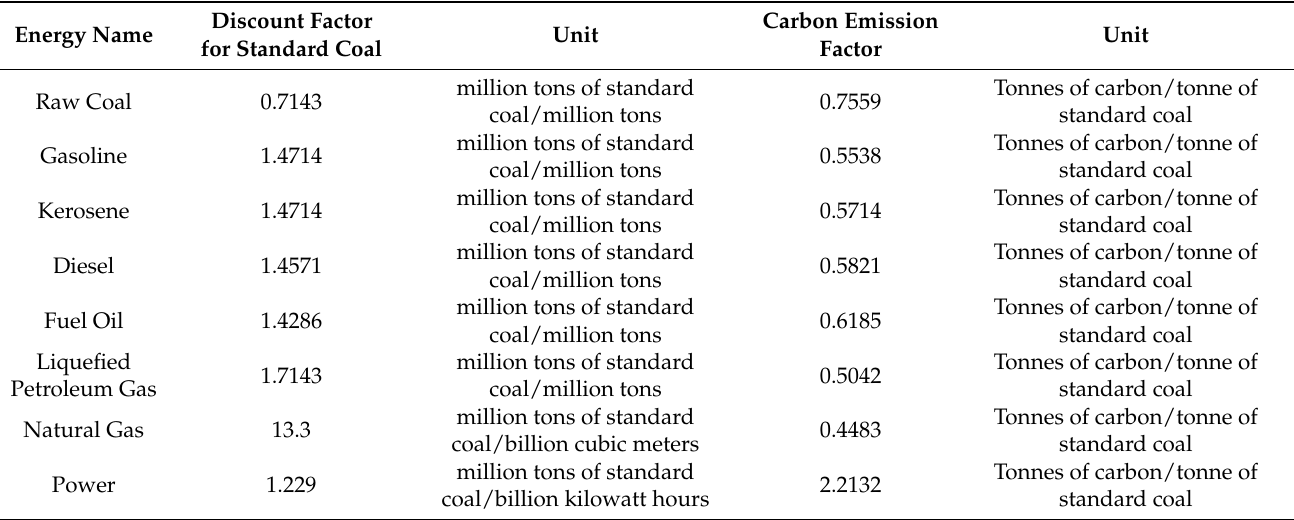
Table 3. Reference factors for the conversion of standard coal and carbon emission factors for various energy sources.